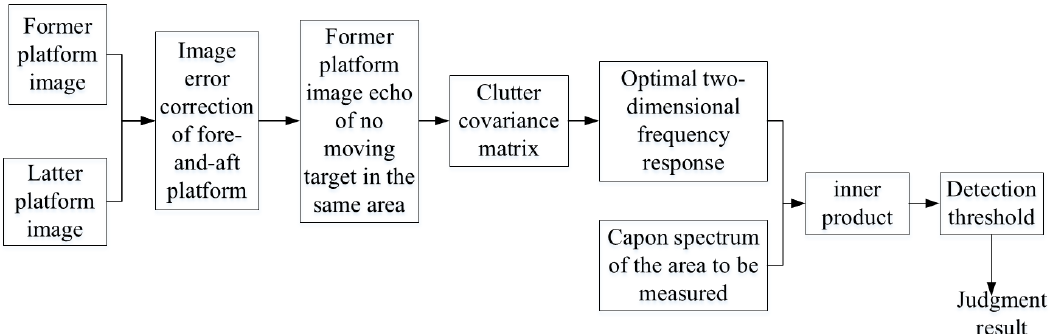
Figure 14. The detection flowchart. The simulated echoes of the background without moving target are shown in Figure